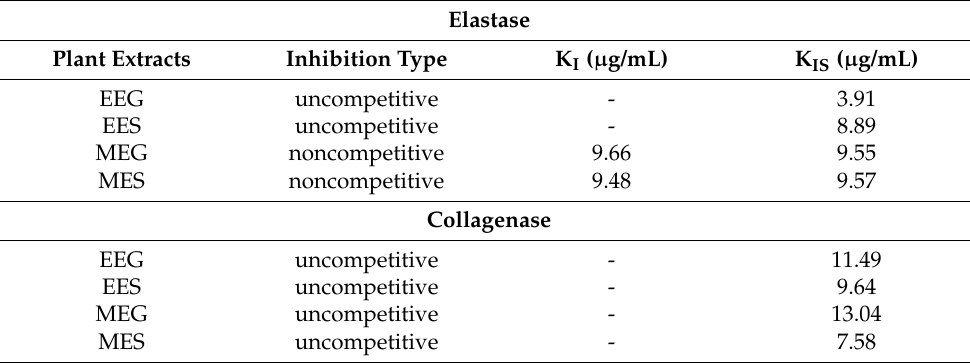
Table 2. Kinetic parameters of elastase and collagenase inhibition by W. filifera extracts. Elastase Plant Extracts Inhibition Type K I ( µ g/mL) K IS ( µ g/mL) EEG uncompetitive -